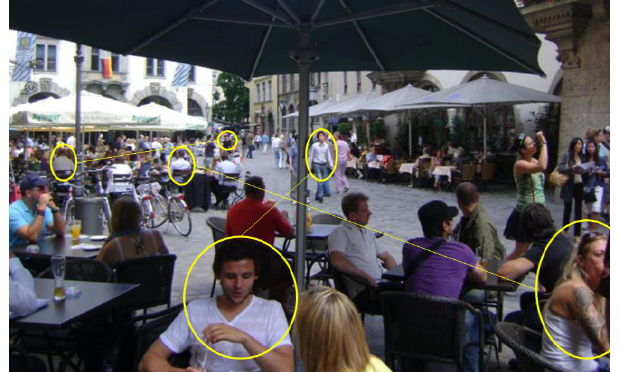
Figure 3. Potential interaction scenario in a pedestrian